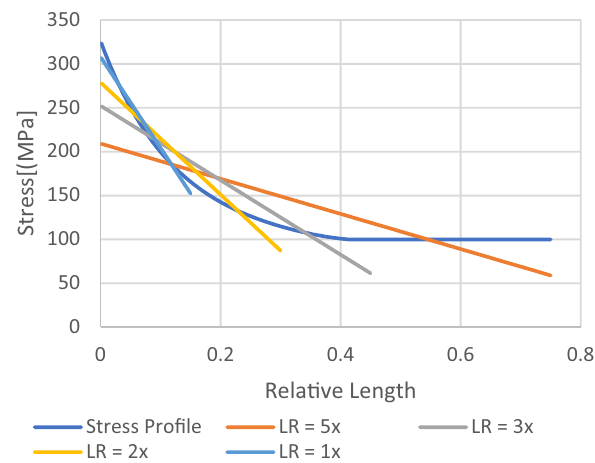
Fig. 6 𝜎 y stress gradient and radial layering around crack opening